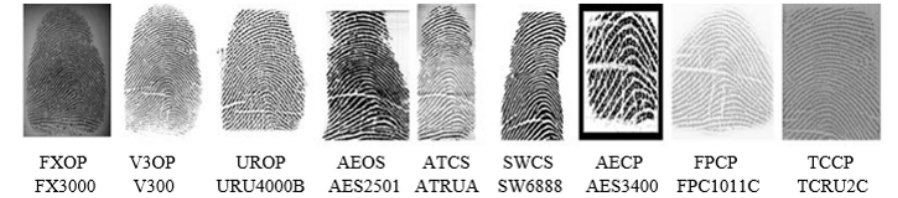
Figure 5. Example Fingerprints of the same finger from FingerPass Database. The first row indicates the name of the dataset name and the second-row the sensor name.